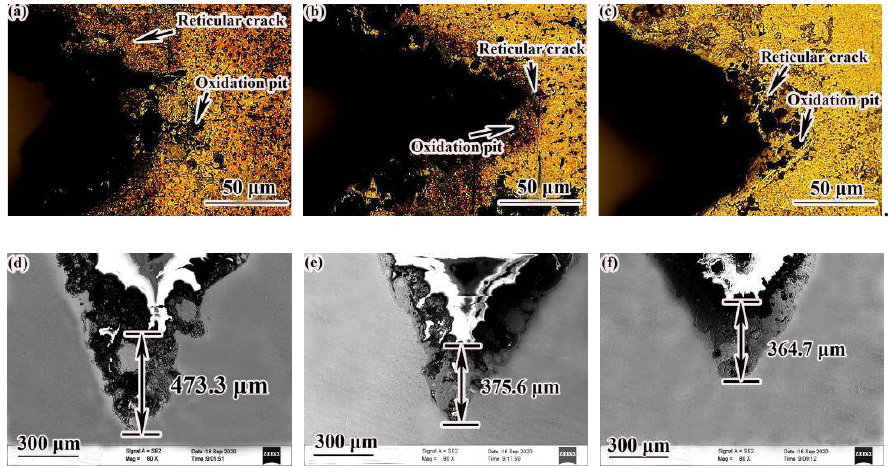
Figure 13. Crack morphology of samples in different states after thermal fatigue test: ( a , d ) as-depos- ited; ( b , e ) SR; ( c , f )